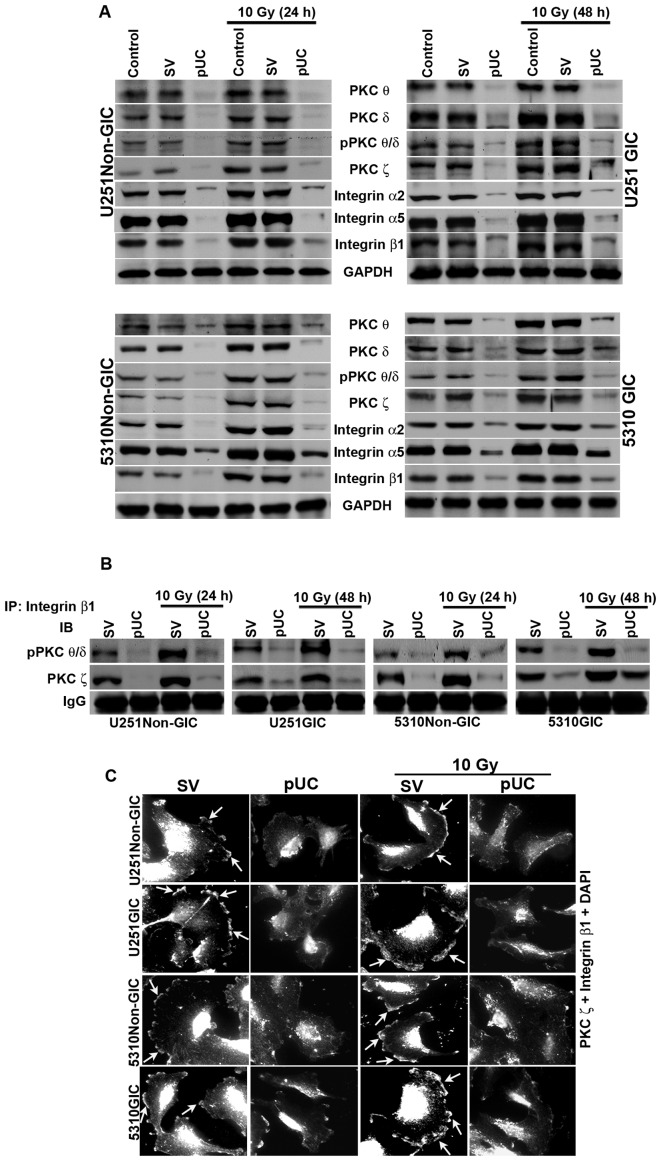
Effect of pUC and radiation alone and in combination on PKC and integrin levels in U251 and 5310 non-GICs and GICs. A, Western blot analysis of the cell lysates of U251 and 5310 non-GICs and GICs showing the protein expression levels of PKC θ, PKC δ, pPKC θ/δ, PKC ζ, integrin β1, integrin α2, and integrin α5 after treatment with pUC and radiation alone or in combination. B, Total protein (300 μg) was collected from pSV, pUC, pSV + 10 Gy and pUC + 10 Gy samples of U251 and 5310 non-GICs and GICs and immunoprecipitated with integrin β1 antibody (2 μg) and protein A plus G agarose beads (20 μg) overnight at 4°C. The precipitates were washed with lysis buffer and the integrin β1 pulled down protein was immunoblotted for pPKC θ/δ and PKC ζ. C, Co-localization of PKC ζ and integrin β1 was carried out with pSV and pUC with and without 10 Gy (24 h for non-GICs and 48 h for GICs). The cells were allowed to migrate on 4-well chamber slides for about 16 h after growing them in Ibidi culture inserts for 24 h after treatments. The cells were fixed, stained with primary antibody overnight at 4°C, counter-stained with species-specific Alexa Fluor-conjugated secondary antibodies, nuclear stained with DAPI, mounted, and imaged under a confocal microscope. Arrows indicating the co-localization of PKC ζ and integrin β1.